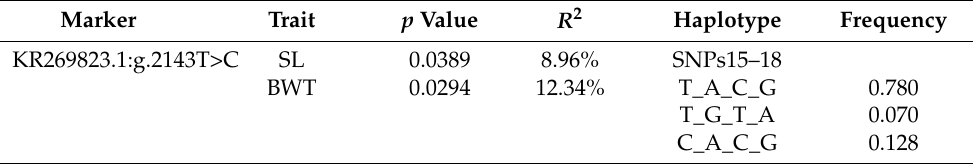
Table 4. Haplotypes significantly associated with growth patterns. Around the detected two associated markers, a block was found to be associated with SL and BWT via a haplotype-based method. The KR269823.1:g.2143T>C marker is denoted as SNP15. The block contained the